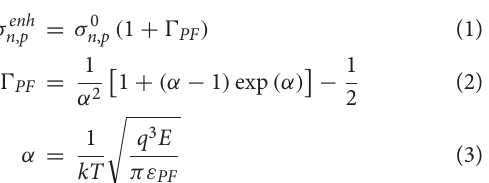
external electric fields ( E ). As shown in Equation (1), the role